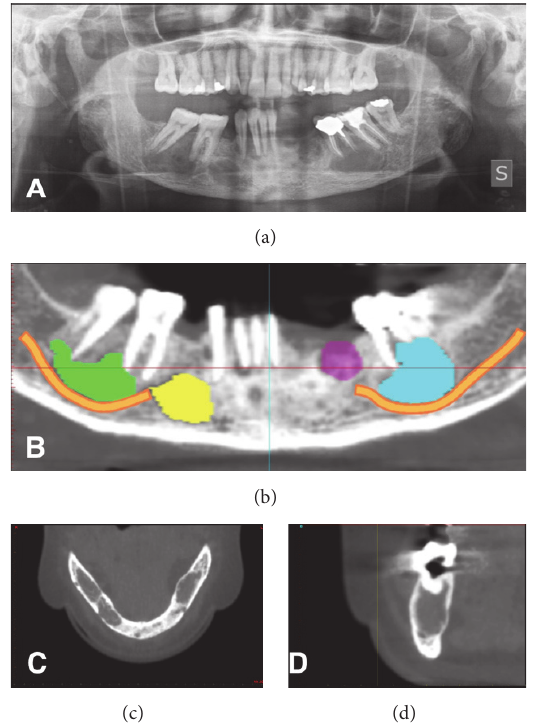
Figure 4: Radiographic appearance after six months. (a) Multiple osteolytic areas involving the mandible bilaterally revealed by another orthopantomogram (b–d) and CT scan six months